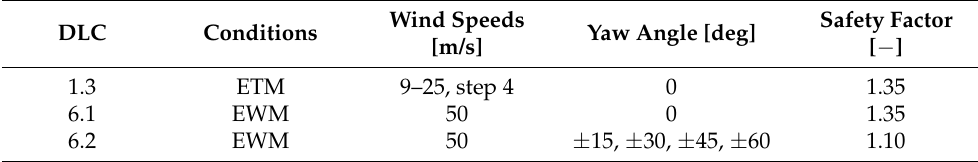
Table 2. DLC definition for ultimate load assessment.